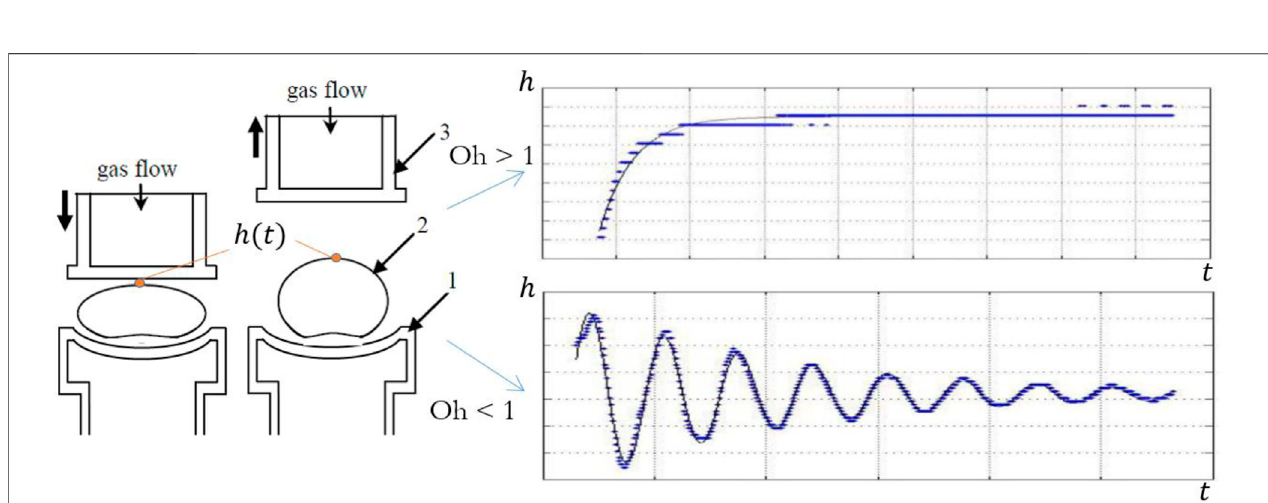
FIGURE 13 | Estimation of dynamic viscosity by droplet apex tracking with VITI-GFL.